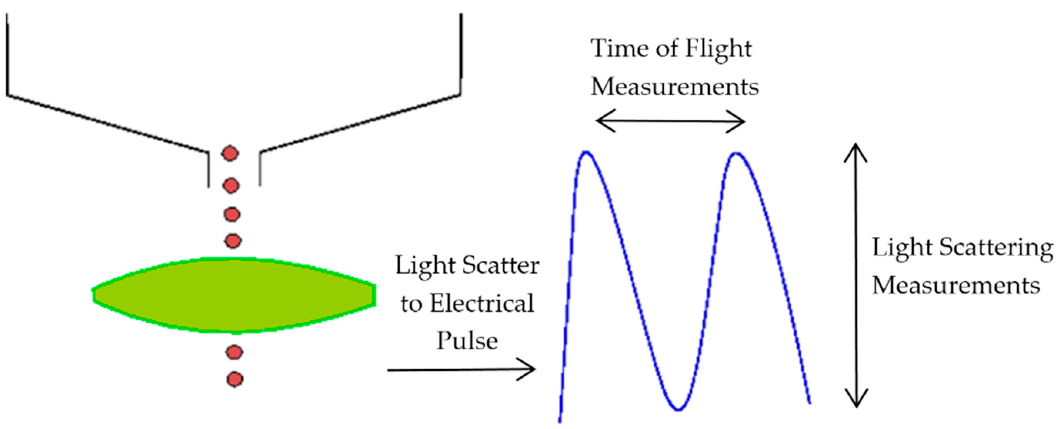
Figure 2. Double-crested signal generated by the Aerodynamic Particle Sizer (APS) laser beams.